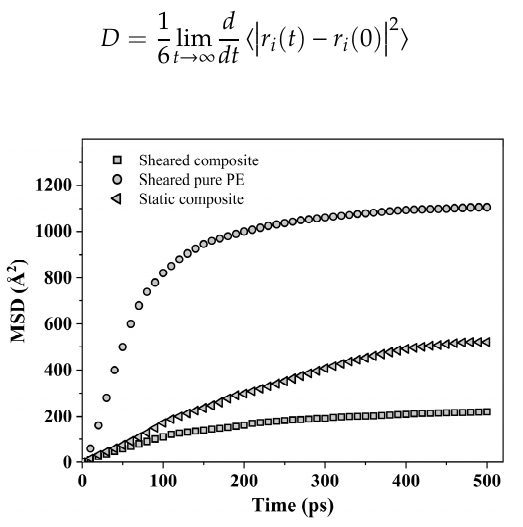
Figure 5. The change in the mean square displacement ( MSD) of PE molecular chains over